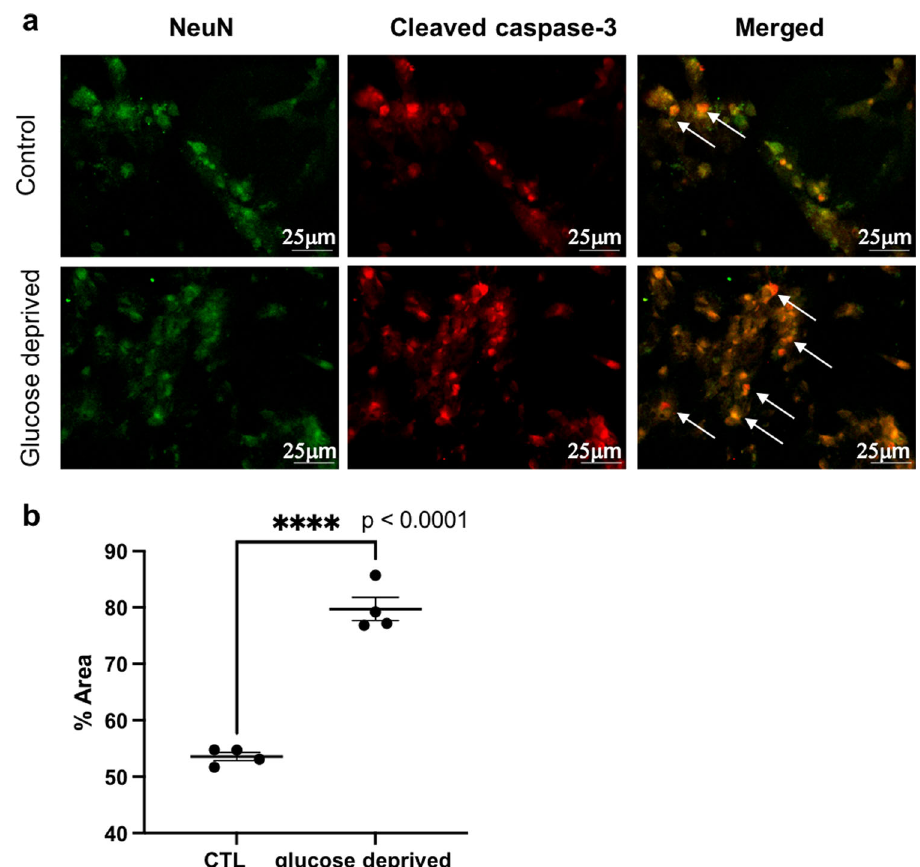
Fig. 4 Neuronal apoptosis in normal and glucose-deprived neuronal cells in vitro. a Images of NeuN positive neuronal cells (green) with cleaved caspase- 3 (red) and coexpression is shown (yellow) in the control and glucose-deprived group. Arrows indicate coexpression. b Graph shows the signi fi cant increase in neuronal cleaved caspase-3 expression after glucose-derivation compared to the control group. Error bars represent mean with SEM. n = 4. **** denote signi fi cant p < 0.0001 using unpaired t test. Scale bar = 25 μ m. CTL